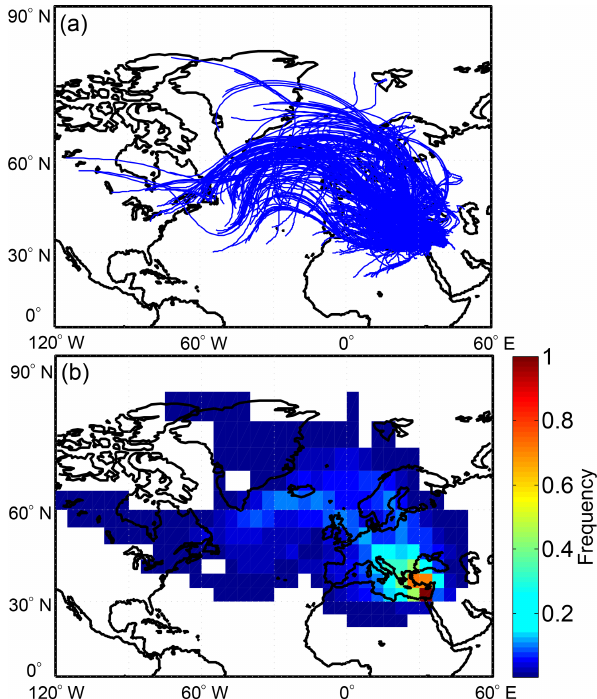
Figure 3. (a) 6d backward trajectories (blue lines) ended at 500m above the measurement station with 1h resolution. (b) Relative fre- quency of trajectories arriving at the station, based on a 5 ◦ by 5 ◦ grid